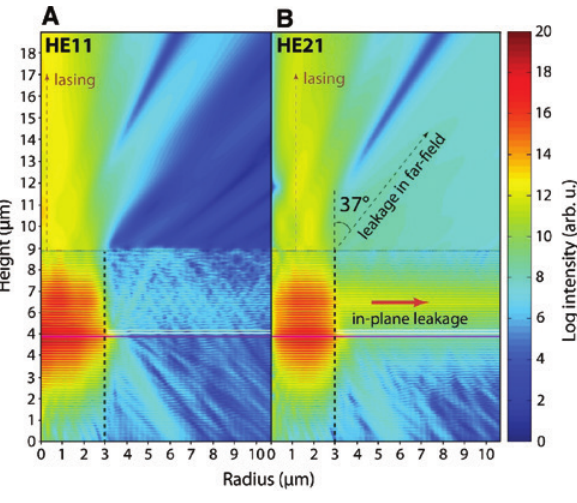
Figure 7: Cross-sectional distribution of the simulated electric field intensity of the fundamental (A) and first excited (B) optical modes of an oxide-confined leaky VCSEL. An active region (magenta line) placed within the cavity is confined by (Al,Ga)As DBRs. The structure contains two oxide-confined aper- tures (oxide layers are shown by white lines). The semiconductor-air interface is shown as the dotted line in the